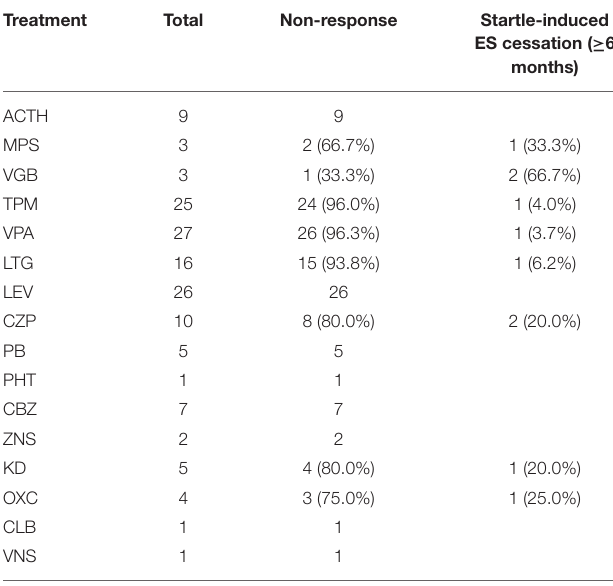
TABLE 5 | Treatment efficacy for startle-induced ES n (%).